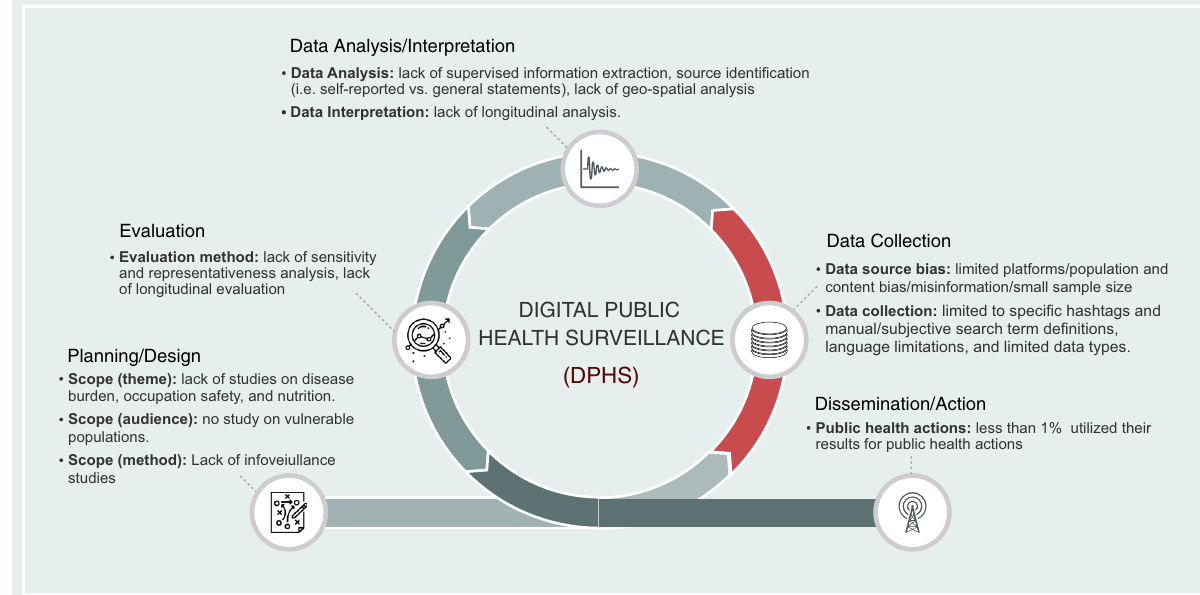
Fig. 8 The overall iterative process of a public health surveillance system. The coloured phase in red highlights the key difference between traditional and digital public health surveillance. The summary of current limitations of research on DPHS discussed throughout this review, is mapped to and listed below each activity of the